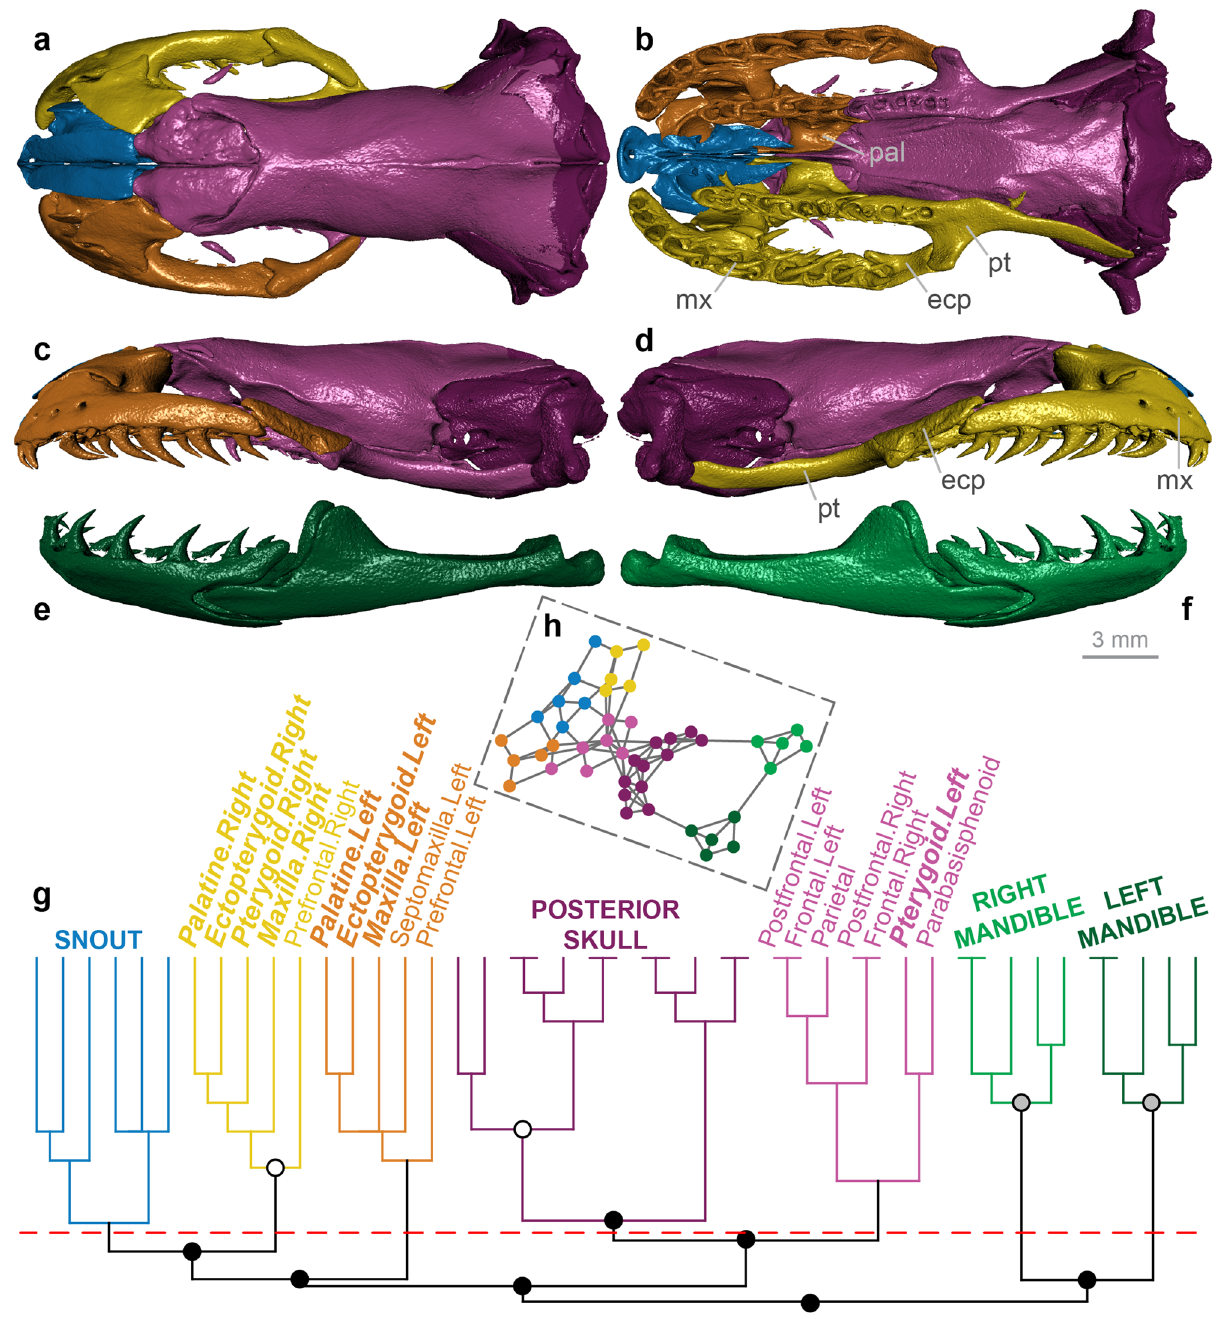
Figure 5. Skull modularity of anilioid snakes. In anilioids, the palatomaxillary elements (in italicized boldface) are integrated to variable extents with the braincase and particularly the snout. ( a–f ) Representative pattern of anilioid skull modularity, illustrated using Cylindrophis ruffus (UMMZ 201901) in ( a ) dorsal, ( b ) ventral, ( c ) left lateral, and ( d ) right lateral views of the skull, and ( e ) left lateral and ( f ) right lateral views of the mandible. ( g ) Network dendrogram of Cylindrophis , reflecting this network architecture. Q-modules are indicated by Q max (represented by the red dotted line). S-modules are indicated by black (p < 0.001), grey (0.001 ≤ p < 0.01), or white (0.01 ≤ p < 0.05) circles. ( h ) Network representation of the skull of Cylindrophis (see Supplementary Fig. S58 for labelled version). ecp ectopterygoid, mx maxilla, pal palatine, pt pterygoid. Dendrogram and network generated in R [v.4.0.3] 122 and RStudio [v.1.3.1093] 123 (see “Methods” section); specimen visualized in Dragonfly [v.4.1] 114